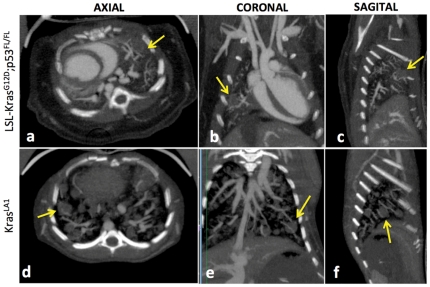
Orthgonal thick slab maximum intensity projection (MIP) images demonstrating visualization of nodule blood supply in the lung cancer models.The images were acquired immediately after administration of liposomal contrast agent.